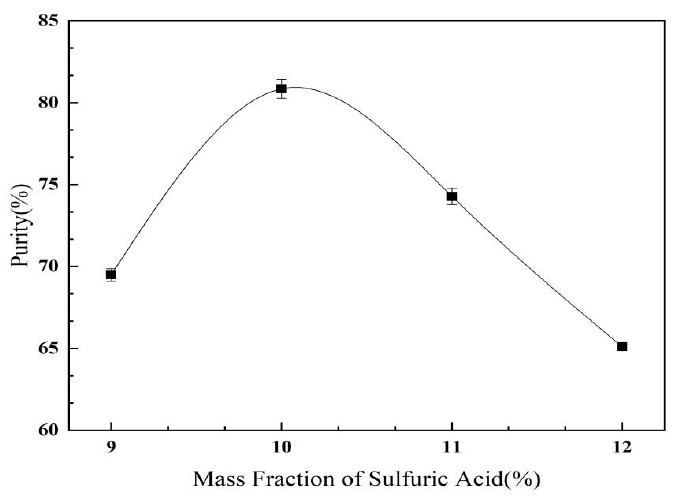
Figure 10. Effect of ammonium sulfate mass fraction on the purity of C. oleifera saponins aqueous two ‐ phase extraction (extraction temperature = 40 °C; mass fraction of propanol = 11%).